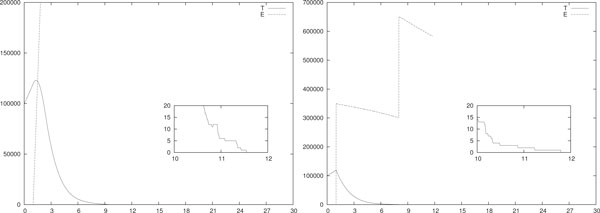
Single run, weekly ACI mono-therapy. Single-run of piece-wise constant (left) and impulsive (right) weekly ACI, i.e. in both panels θi = 7i + 1 for i = 0, . . . , 3. In (left) A = 1.4 days and bi = 35 · 104/V A i = 0, . . . , 3. In (right) wi = 35 · 104 for i = 1, . . . , 3. All the other parameters are as in Table 3.